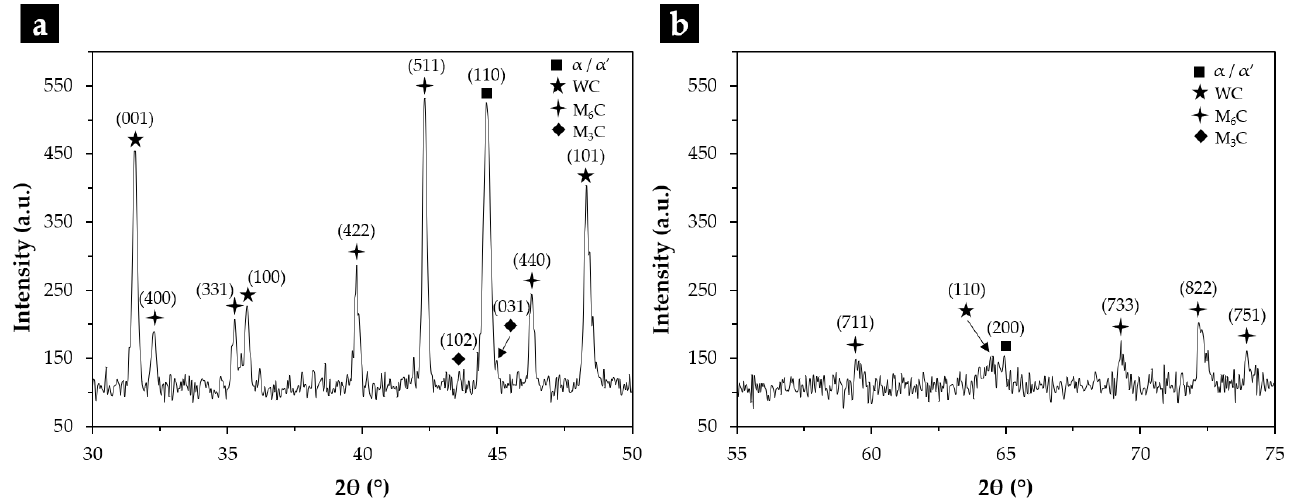
Figure 3. XRD patterns of the composite in the 2θ range of 30°– 50° ( a ) and 50° – 80° ( b ), identifying the type of carbides and other phases present.